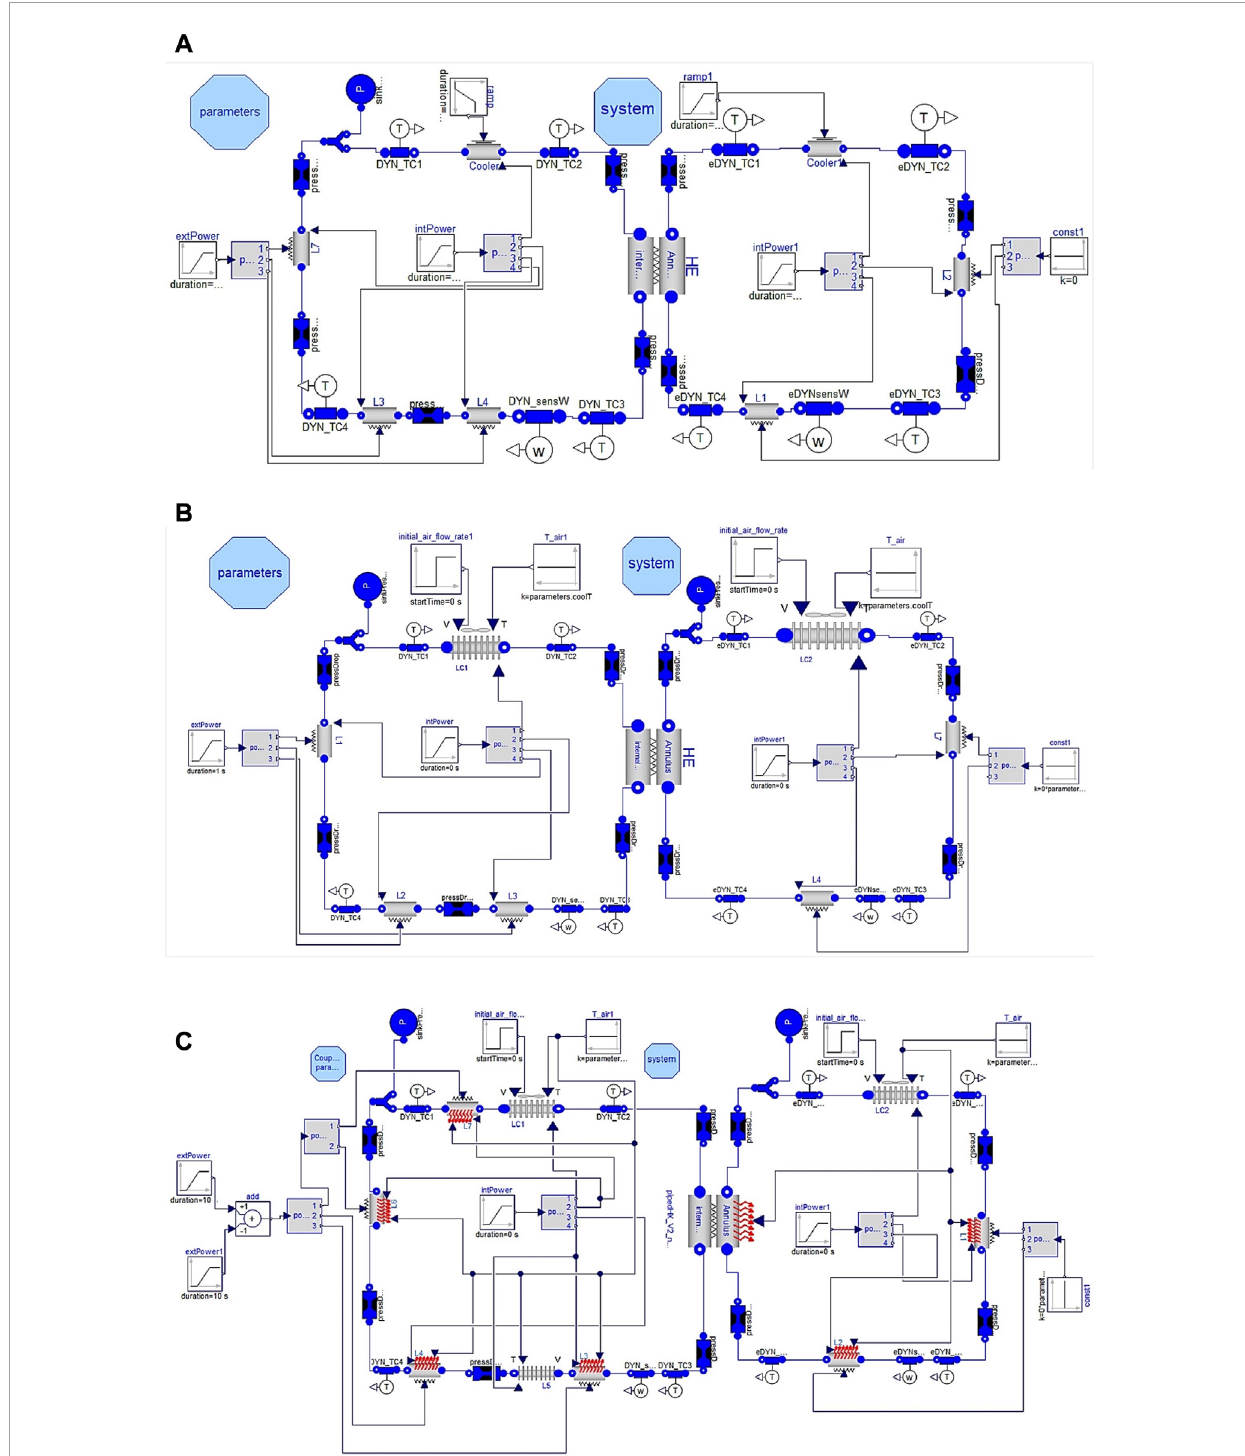
FIGURE 6 Different developed DYNASTY–eDYNASTY models: (A) preliminary adiabatic model with thermostated coolers, (B) adiabatic model with finned coolers, and (C) model with heat losses included.